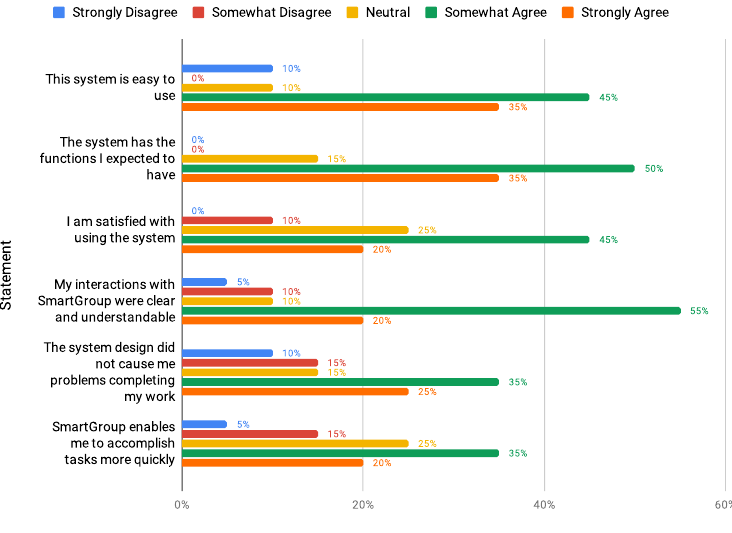
Figure 4. Likert-scale user responses regarding system user